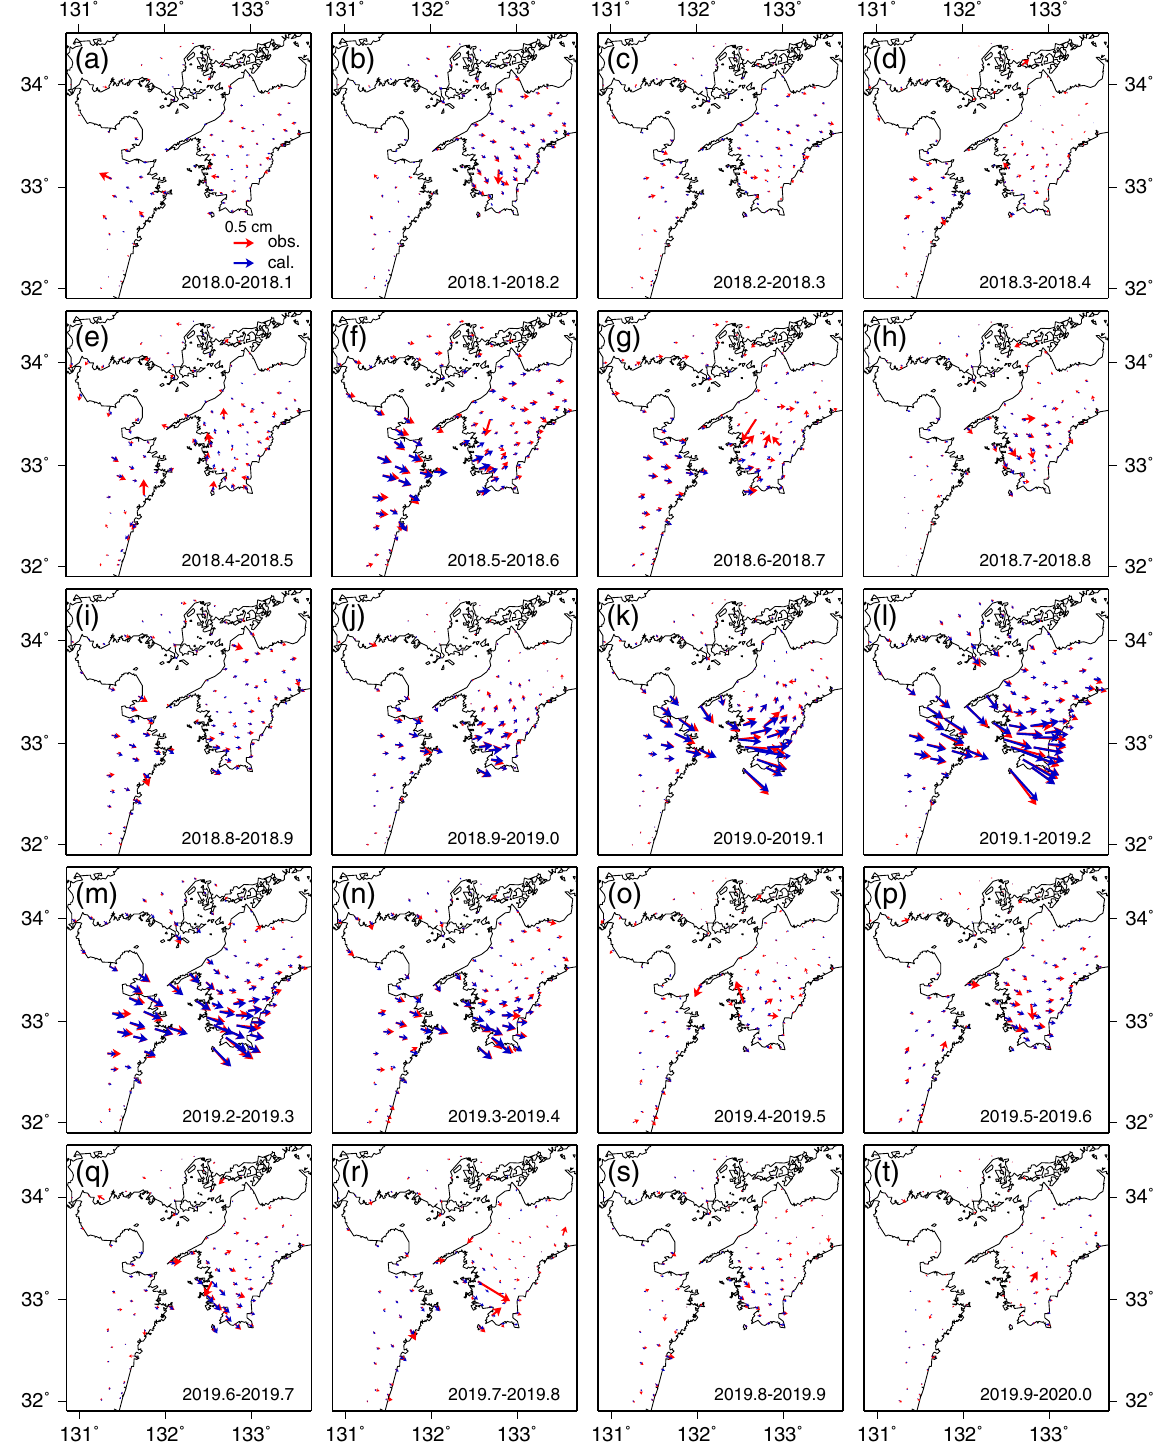
Figure 2. Spatial distribution of horizontal displacement fields associated with the Bungo Channel L-SSE at each 0.1-year time step between 2018.0 and 2020.0. The red and blue arrows indicate the observed displacements and the calculated displacements obtained from the spatiotemporal slip distributions shown in Fig. 4, respectively. Each 0.1-year time period is shown in each panel. The scale of 0.5 cm for the arrow is shown in ( a ). The map was created by using the Generic Mapping Tools (GMT) 15 (version: GMT 4.5.7, URL link: https:// www. gener ic- mappi ng- tools. org/ downl